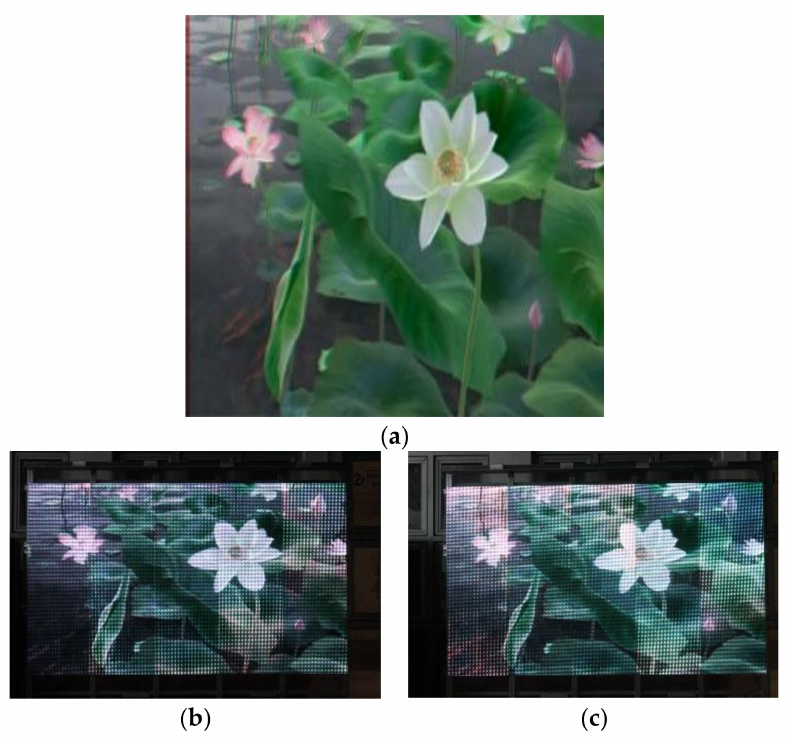
Figure 9. ( a ) The original stereo anaglyph of “lotus”; the left ( b ) and right ( c ) stereo image displayed on the prototype.